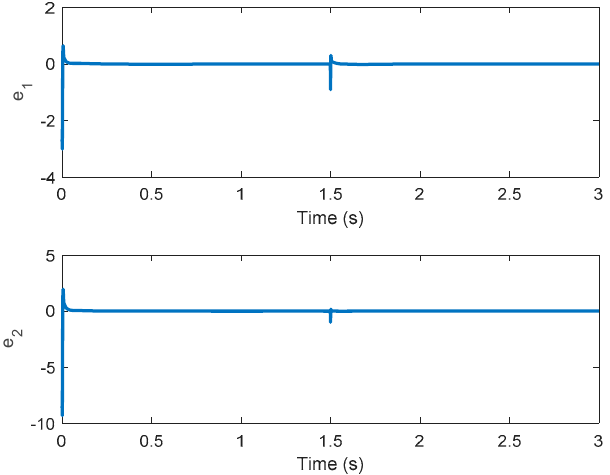
Figure 2. Timeresponsesoftheclosed-loopsystemwiththefixedPIDcontrollerandunknownperturbation. Figure 2. Time responses of the closed-loop system with the fixed PID controller and unknown perturbation.